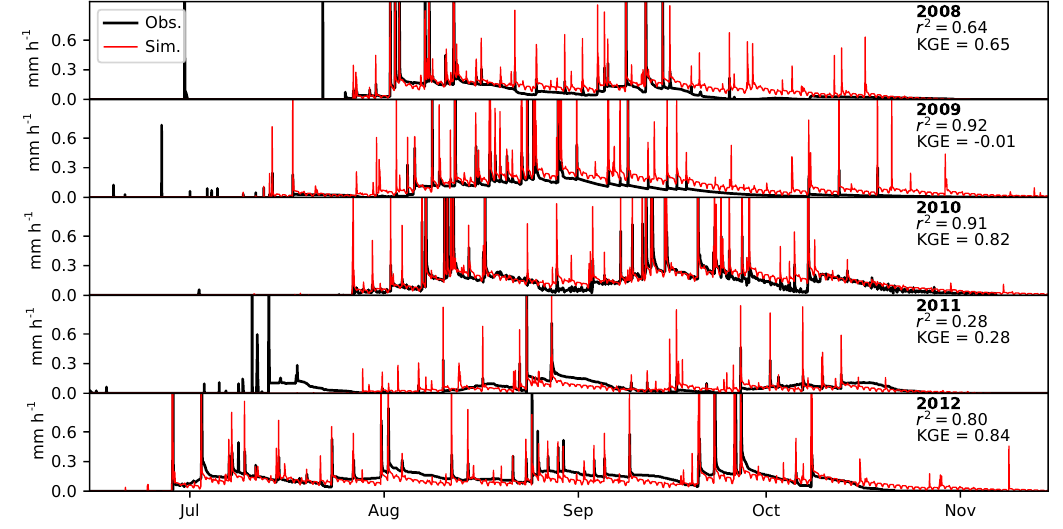
Figure 5. Observed and simulated streamflow for the wet seasons of the period 2008 to 2012 at station